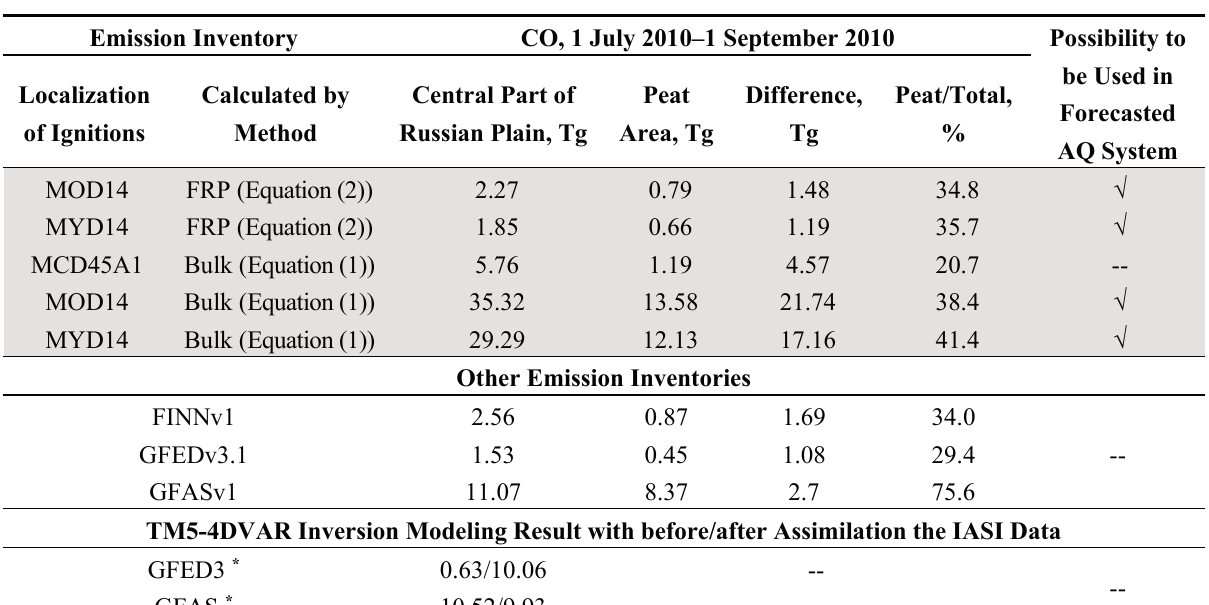
Table 1. Total CO emission from wildfires in the central part of Russian plain (grey area in Figure 1b) between 1 July and 1 September 2010, calculated by different methods. The emission values of fire at peat areas (hatch areas in Figure 1c) and their percentage are specified. The emissions, calculated in this study are